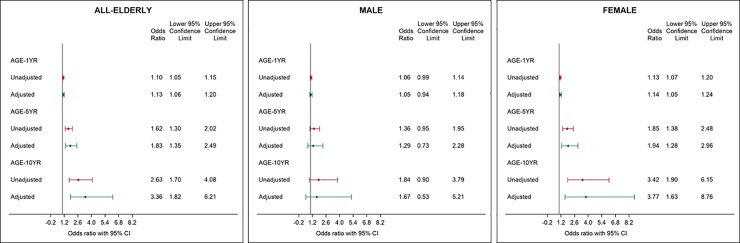
Association between low ASMI and age increment (1 year, 5 years, 10 years) using logistic regression models in (A) all older people* (n = 398), (B) Males† (n = 181), and (C) Females‡ (n = 217). A. *Adjusted for gender, BMI and calf circumference. B. †Adjusted for BMI and bone mass. C. ‡Adjusted for BMI, calf circumference and bone mass.